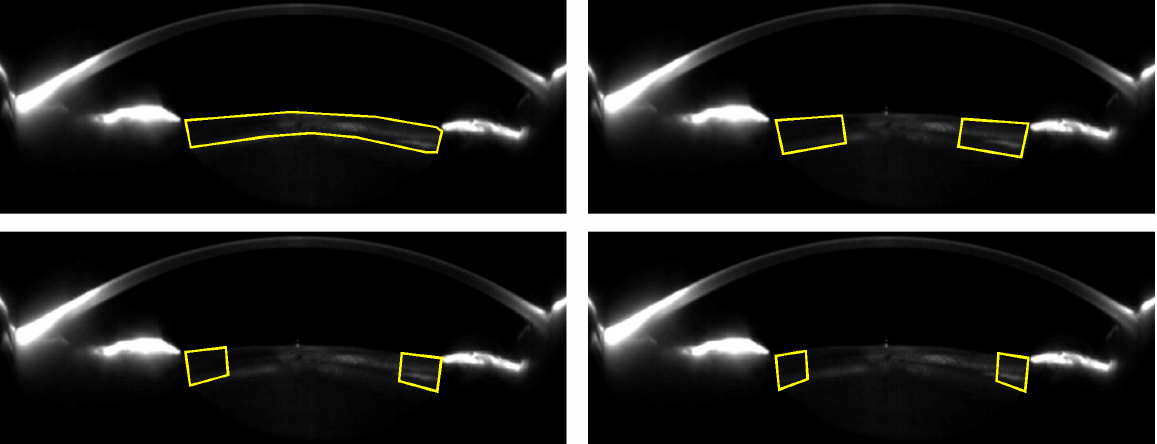
Fig 2. Region of Interest (ROI) for Measuring Cortical Cataracts Superimposed upon the Scheimpflug Image Used. A: ROI to analyse the whole cortex. B: ROI to analyse half cortex. C: ROI to analyse third cortex. D: ROI to analyse quarter cortex.